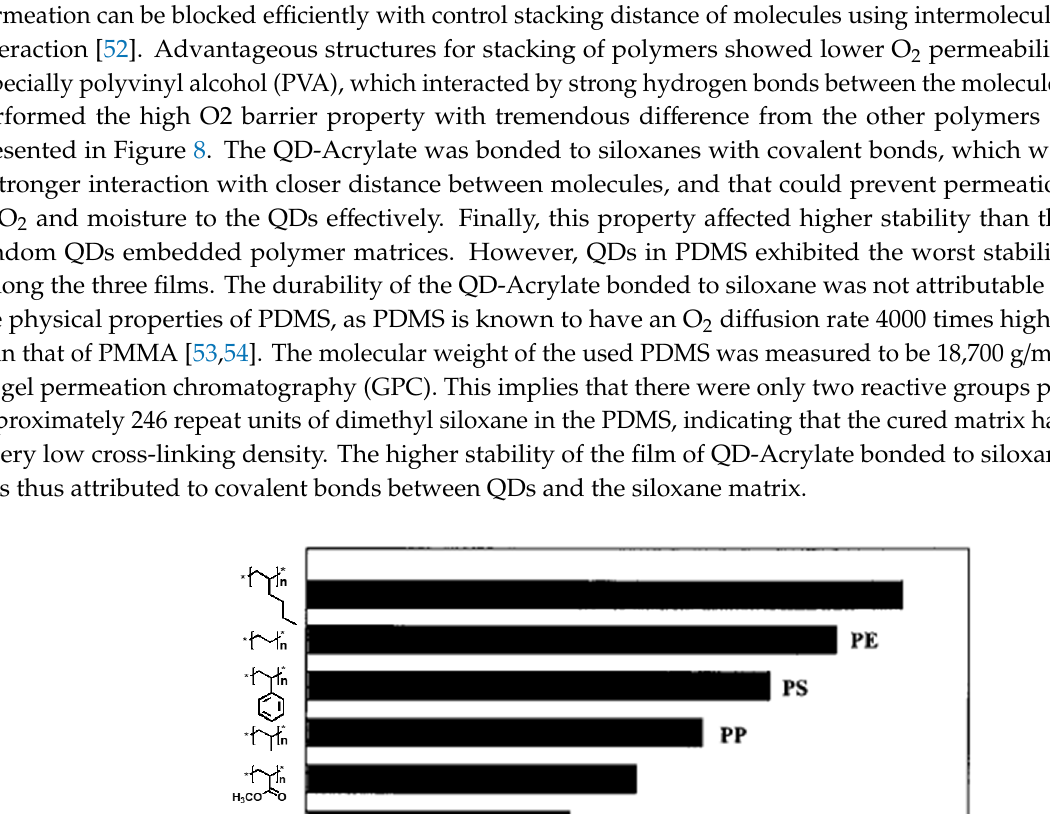
Figure 8. Structural effect for O 2 barrier property in polymeric materials [52].